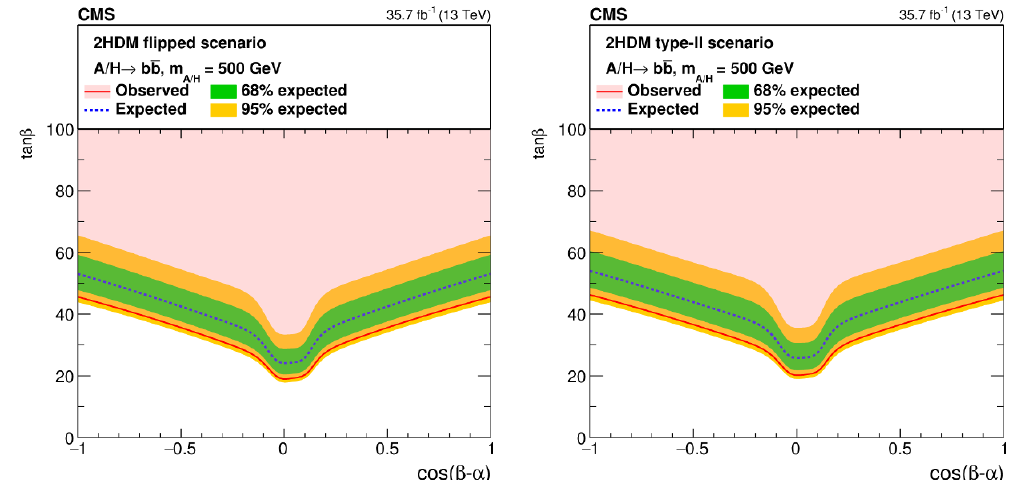
Figure 9 . Upper limits for the parameter tan (cid:12) at 95% con(cid:12)dence level for the (cid:13)ipped (left) and type-II (right) models as a function of cos( (cid:12) (cid:0) (cid:11) ) in the full range of [ (cid:0) 1 : 0 ; 1 : 0], for the mass m H = m A = 500 GeV. The inner and outer bands indicate the regions containing 68 and 95%, respectively, of the distribution of limits expected under the background-only